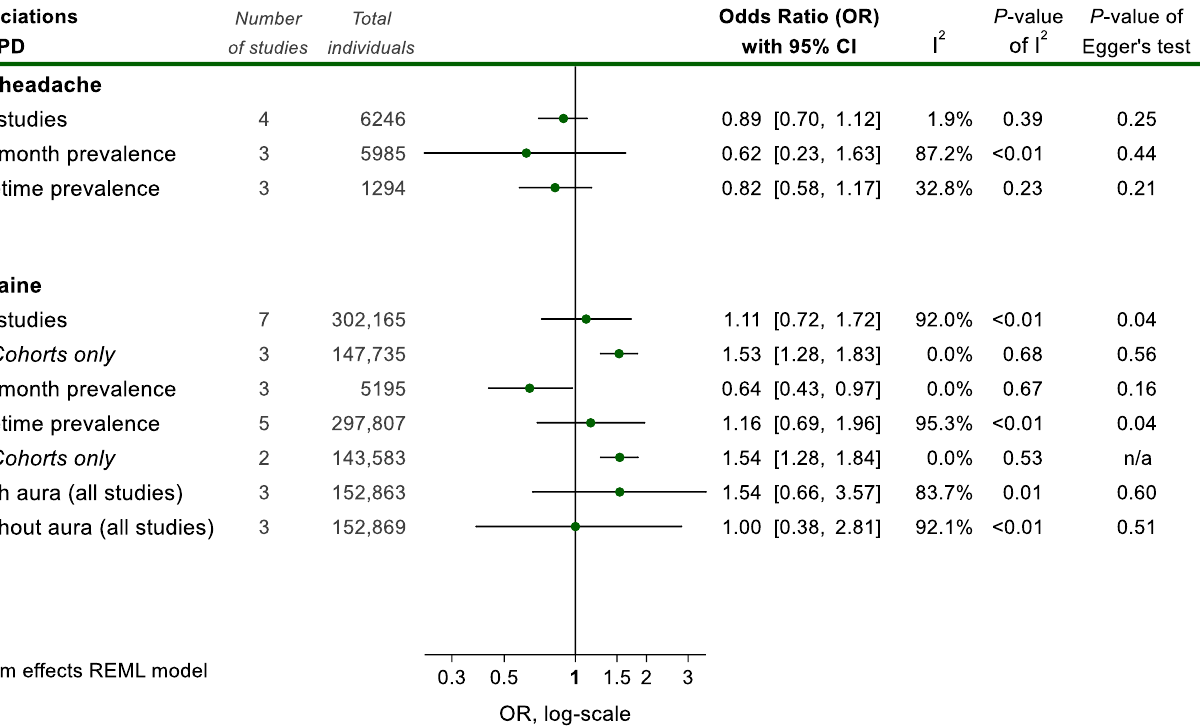
Figure 4. Meta-analyses of associations between headache and Parkinson Disease (PD) status. Results of each individual random effects meta-analysis (odds ratios (OR)) are depicted as green data markers; 95% confidence intervals (CI) are indicated by the black error bars. I 2 reflects each meta-analysis heterogeneity.